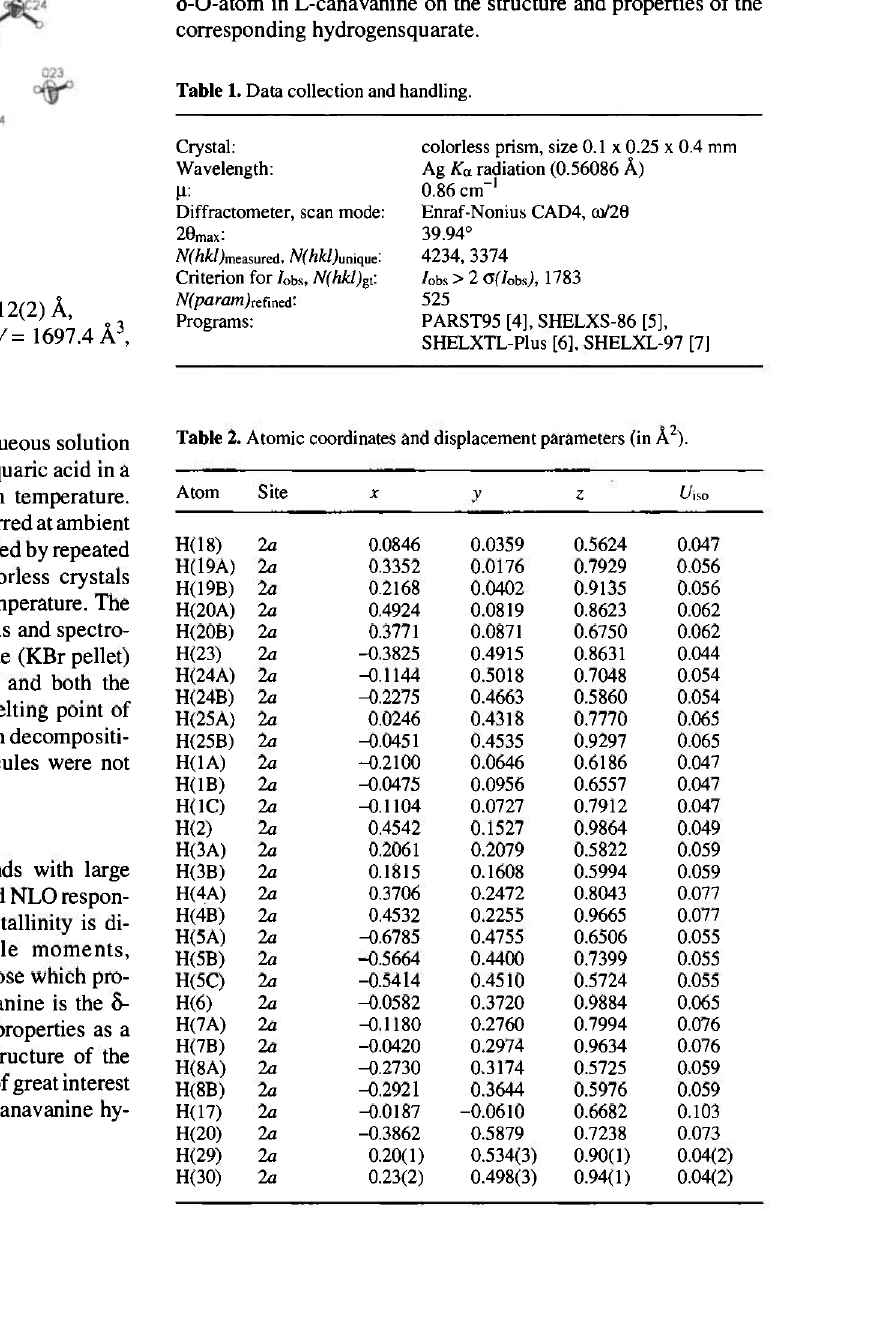
Table 1. Data collection and handling.